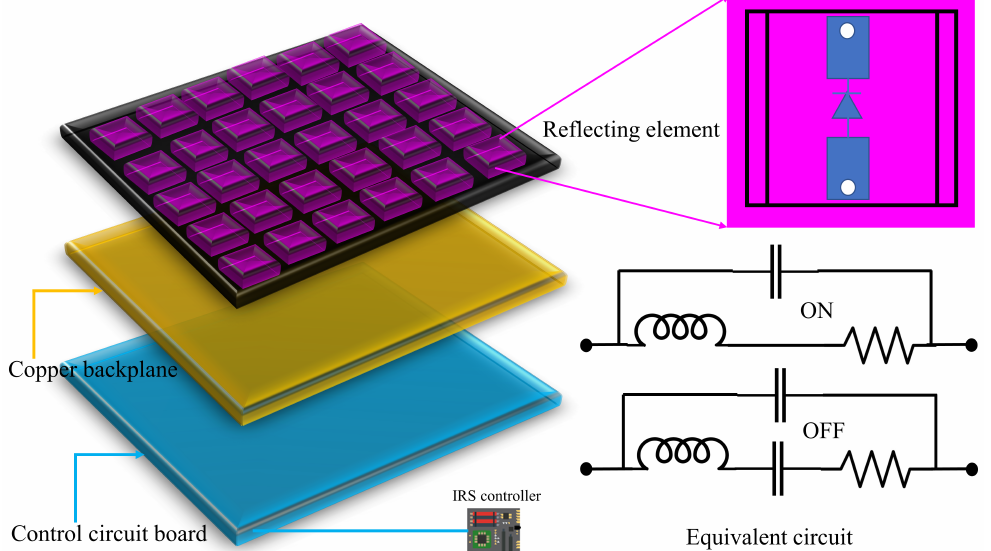
Figure 1. The architecture of reconfigurable reflecting element based on PIN diode with different